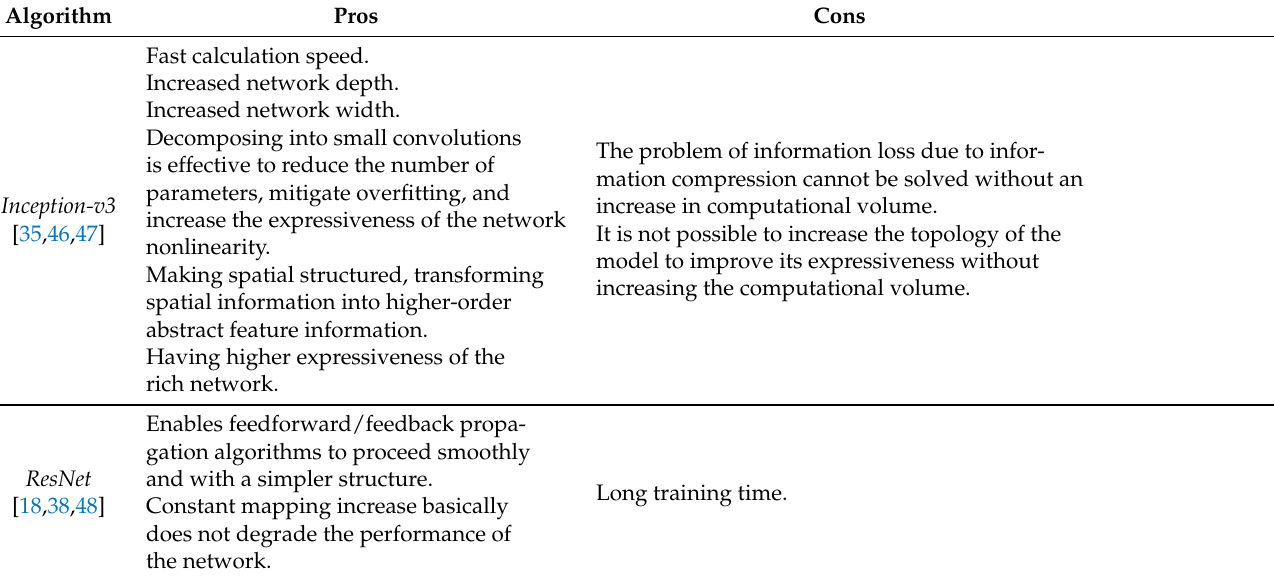
Table 6. Intelligent mineral identification methods based on Inception-v3 and ResNet